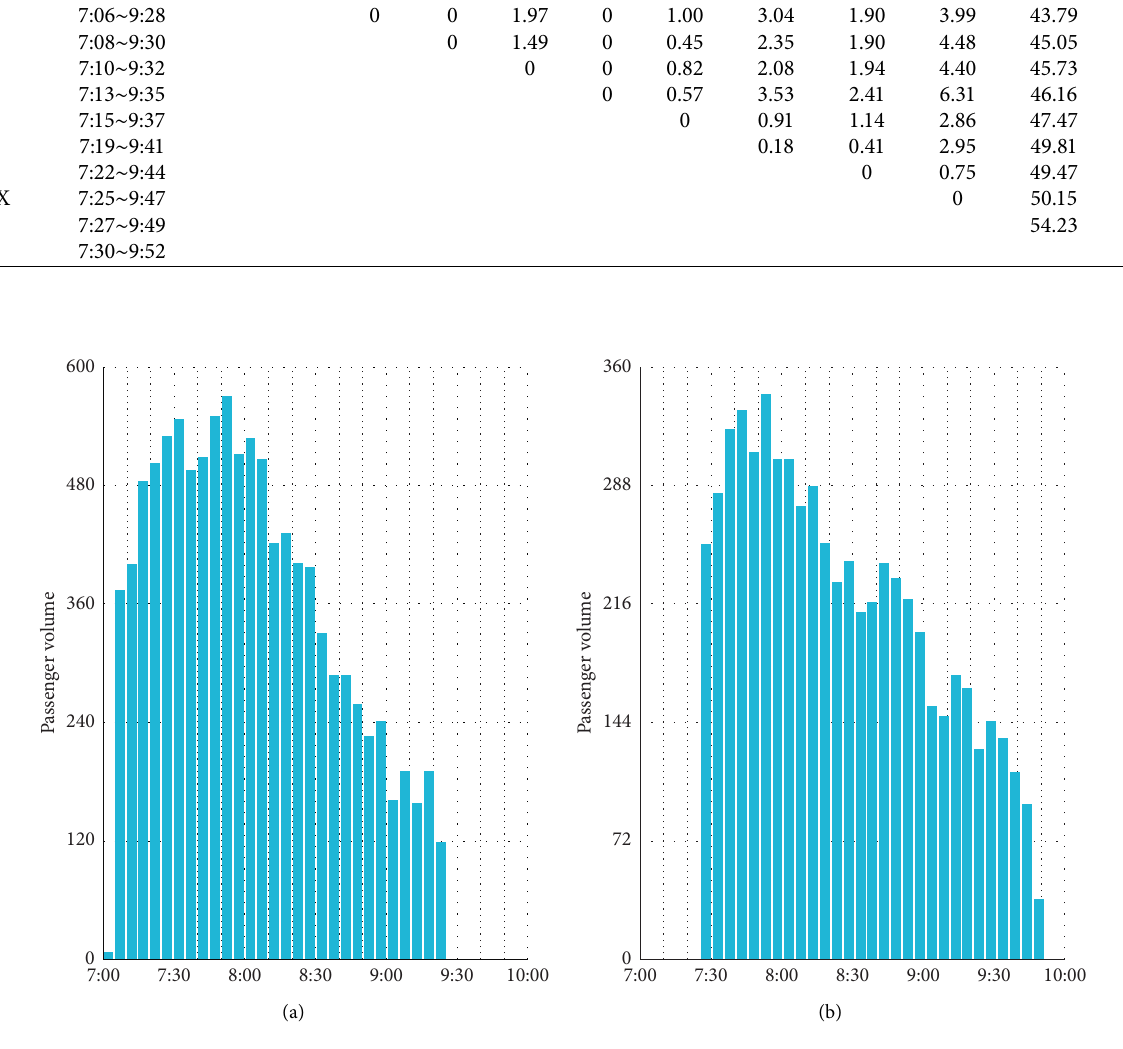
Figure 7: Time-varying passenger volumes at (a) TQ Station and (b) CMDX Station.